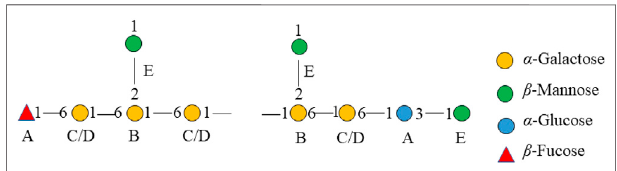
FIGURE 7 | Fragment of the chemical structure of Glycosyl linkages of PPp-W were identi fi ed by GC – MS and listed in Table 1 . There were fi ve main glycosyl linkages in PPp-W including → 2,6)-Gal p -(1 → (23.11%), → 6)-Gal p -(1 → (21.84%), Man p -(1 → (25.32%), → 3)-Glc p -(1 → (6.81%), and Fuc p -(1 → (1.12%). The proportions of Gal, Man, Glc, and Fuc were basically consistent with the ratios of monosaccharide composition. On the basis of monosaccharide composition, → 6)-D-Gal p -(1 → was derived from both 6-O-Gal p and 6-O-